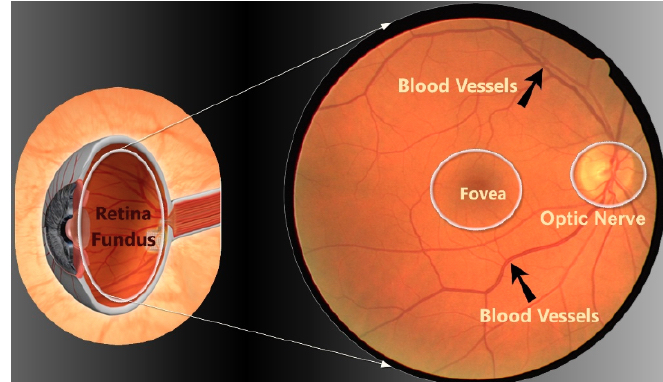
Figure 2: Retinal fundus image